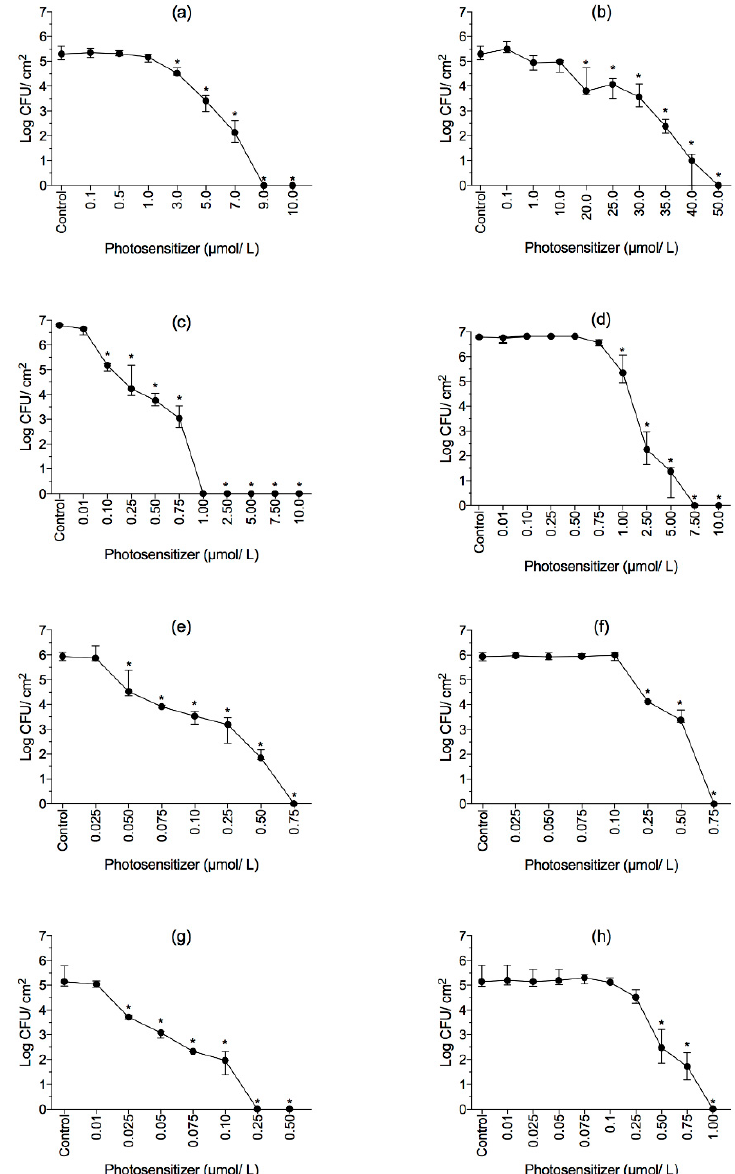
Figure 5. The survival of biofilms cells formed by ( a , b ) E. coli , ( c , d ) S. aureus , ( e , f ) E. hirae and ( g , h ) L. innocua subjected to aPDI using RB (left) and ERY (right). Biofilms were incubated for 30 min in the dark and illuminated with green LED light source for 30 min. The control group represents the cells incubated only with PBS. Values are shown as medians, including 25% and 75% quantiles of at least three independent experiments. * p < 0.05 compared to the control.